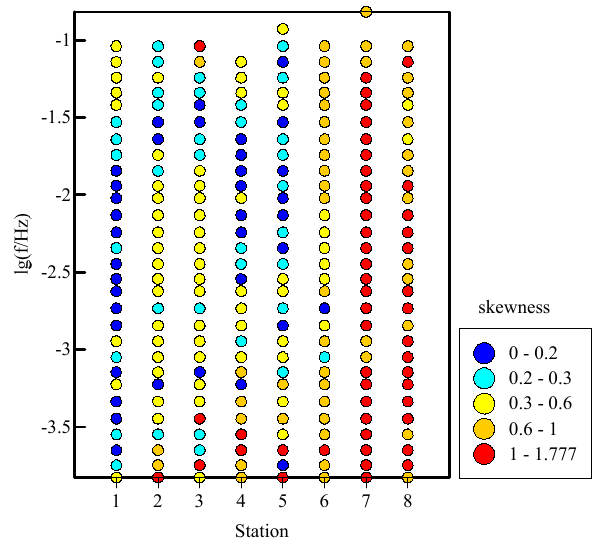
Figure 4. 2D skewness values by Bahr impedance tensor decomposition technique. The most 2D skewness values are greater than 0.3.